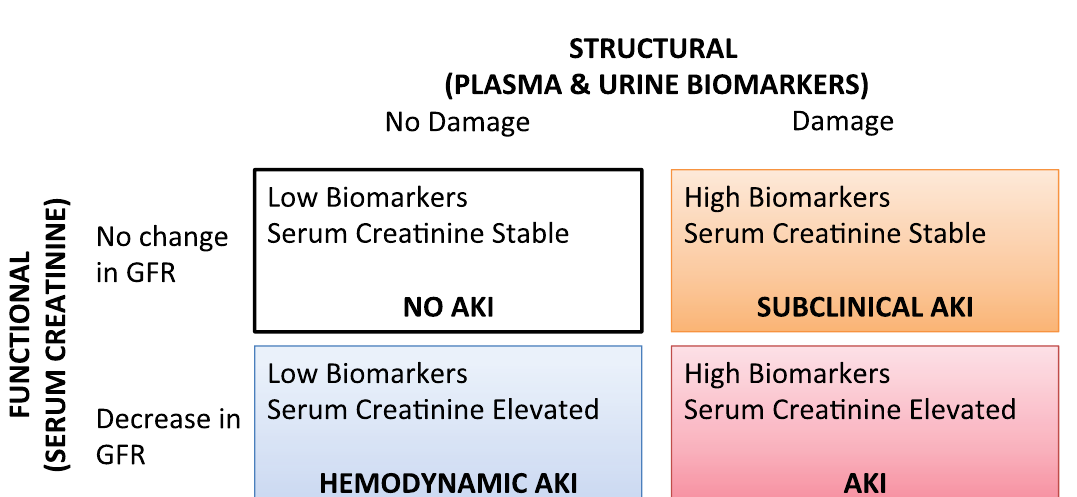
Figure 2. Structural versus functional classification of AKI. Adapted from 74. AKI, acute kidney injury; GFR, glomerular filtration